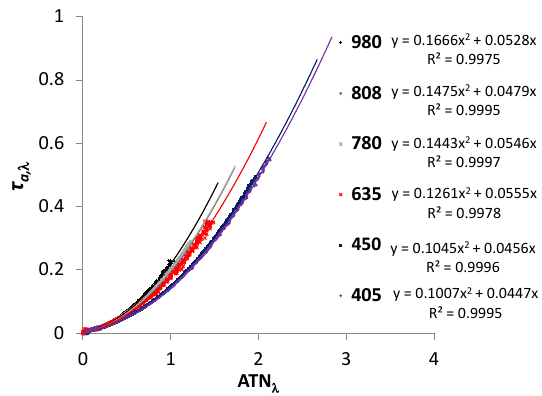
Figure 4. 7 Figure 4. Relationship of EC concentration, [EC], versus 8 ATN 635 nm from all 1s measurements during the EC2 step (740 ◦ C in a 98% He / 2% O 2 atmosphere) of IMPROVE_A analysis for a diesel exhaust sample (CIFQ074 from the Gas/Diesel Split Study (Fujita et al., 2007)). Also shown are paired [EC]–ATN 635 nm of 11 diesel exhaust samples, where EC is determined from IMPROVE_A and ATN 635 nm from initial filter transmittance. Circles and er- ror bars indicate the average and spread, respectively, of EC by transmittance and reflectance (i.e., ECT and ECR, respectively). τ a,635 nm was further calculated from a MAE of 7.4m 2 g − 1 × [EC], and the regression result between τ a,635 nm and ATN 635 nm is shown in green.